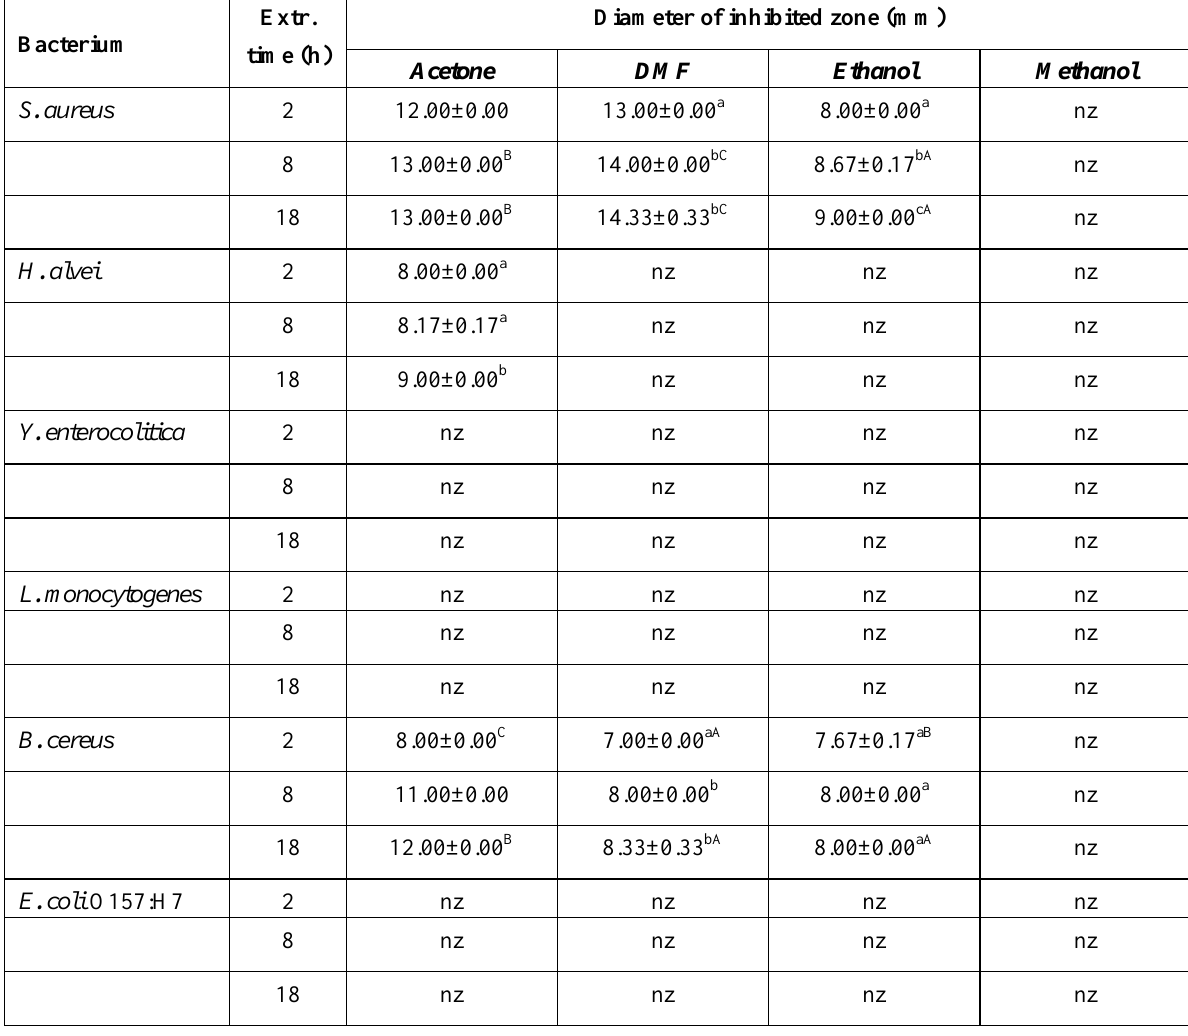
Table 3. Antibacterial activity of black tea aqueous extracts. Diameter of inhibited zone